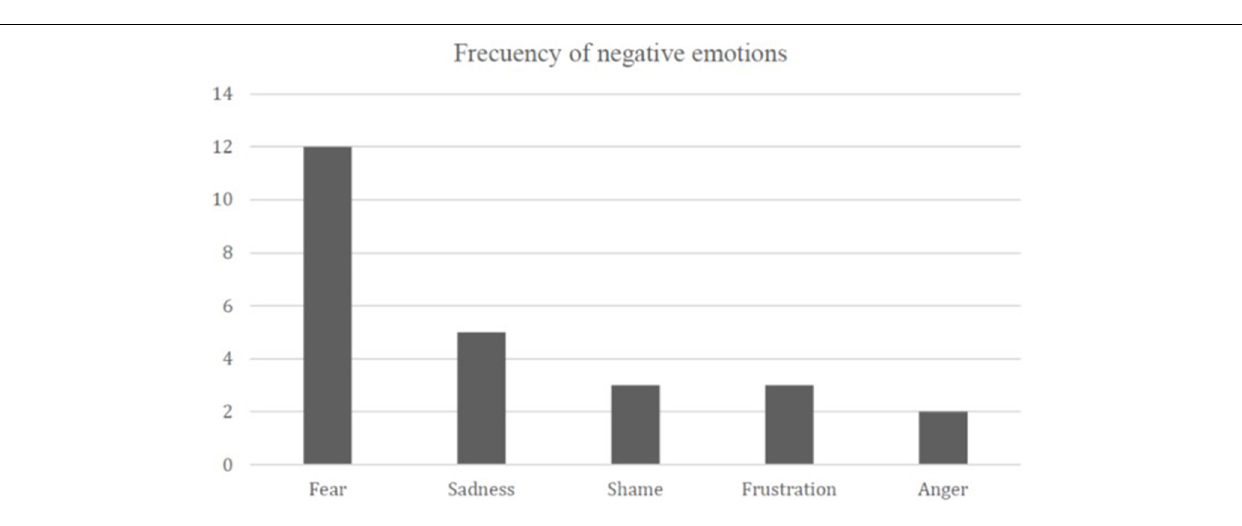
FIGURE 7 | Frequency of negative